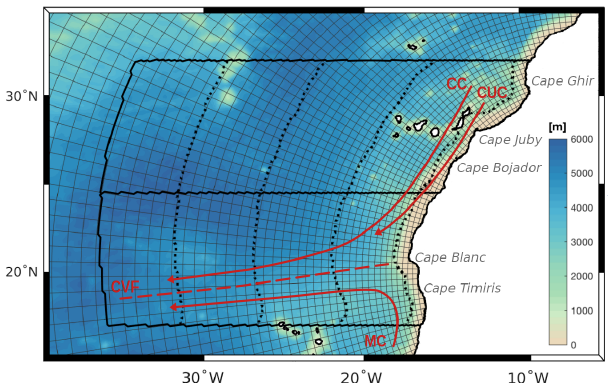
Figure 1. Atlantic telescopic grid zoomed around the region of study with every fifth grid line plotted. Black solid contours high- light the northern and central subregions of study. Black dotted lines indicate the offshore boundaries at 100, 500, 1000, and 1500km from the coast. Red lines provide a simplified scheme of the mean regional pattern of currents: Canary Current (CC), Canary Up- welling Current (CUC), Mauritanian Current (MC), and Cape Verde Front (CVF). Shading: depth of topography